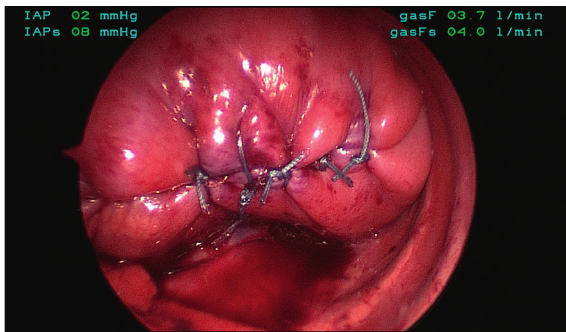
Figure 2: Image of diaphragm flattened following vertical row of sutures, slight dome shape is noted, however, not under any re- markable